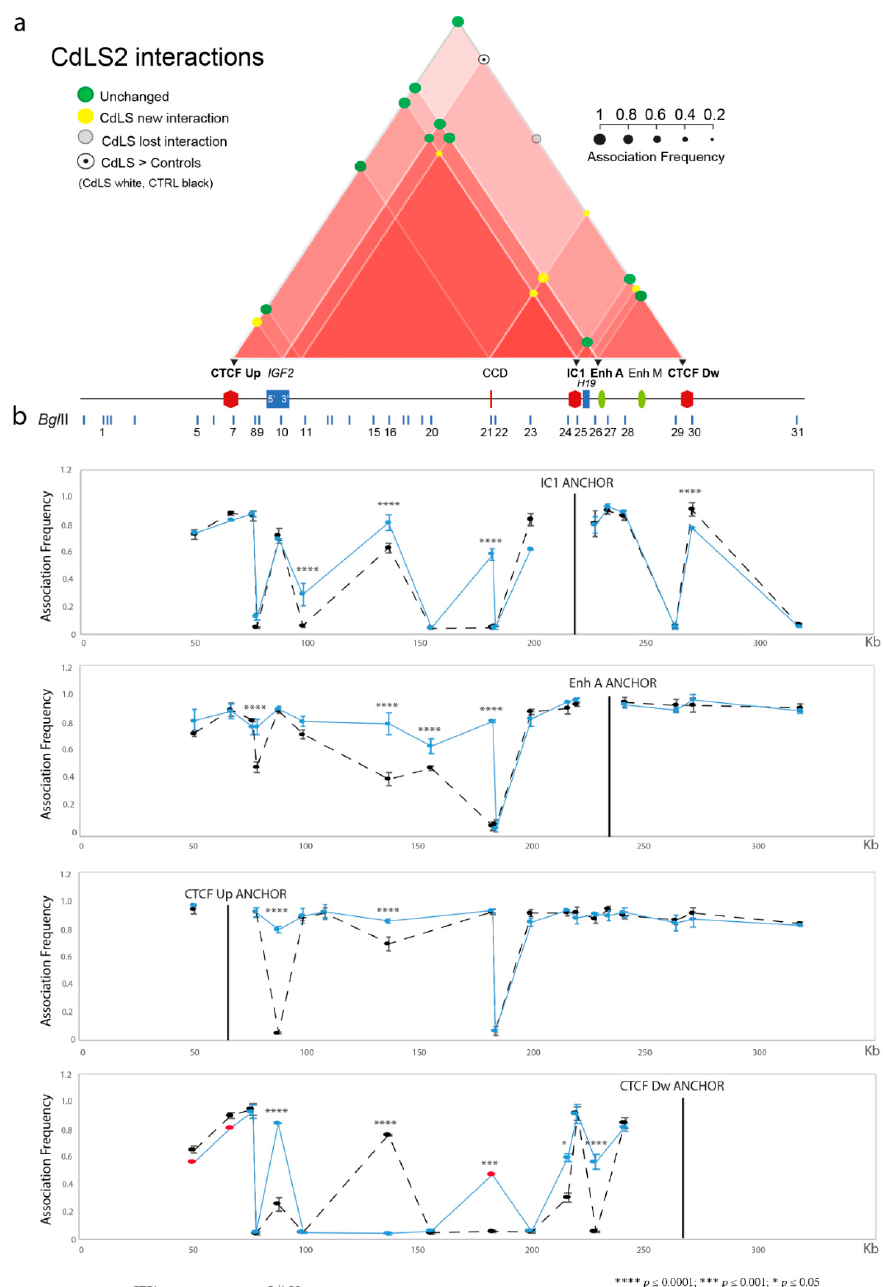
Figure 3. Abnormalities in chromatin architecture at the IC1 locus of the CdLS2 cell line ( SMC1A mutation). The figure is to scale. ( a ) Scheme of the statistically significant modifications in the chromatin interactome of the IC1 domain in the CdLS2 cell line compared with the mean of the controls. Interactions between different elements of the IC1 region are shown by red triangles; increasing color intensity corresponds to an increase in the number of interactions of the subregion. An interaction lost selectively in the CdLS2 cell line is shown in light grey. Colored circles represent association frequencies as described in the figure. Black triangles indicate the anchors used for 3C analysis. A linear representation of the IC1 imprinted domain is depicted below the interactome. ( b ) IC1 locus looping profiles for the indicated anchors in controls (dotted black) and CdLS2 (light blue) cell lines. BglII restriction sites are indicated above. Each point in the profile is the mean ± standard deviation of two independent 3C experiments and indicates the association frequency between the anchor and the fragment on the left of the corresponding BglII restriction site. Differences (two-way ANOVA test) are indicated by asterisks. Red dots indicate the points with standard deviation